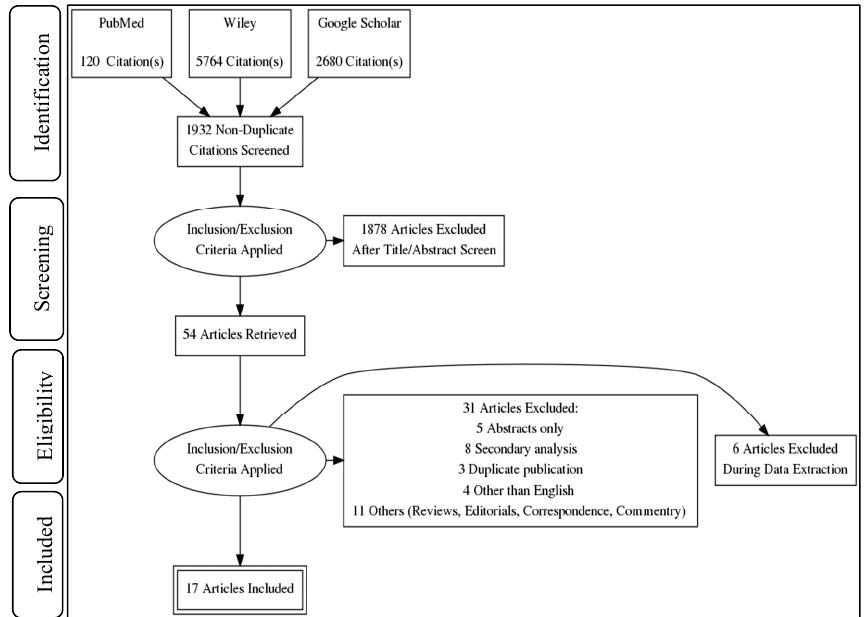
Figure 1. PRISMA flow diagram. The implementation of inclusion and exclusion criteria in a step-by-step manner determined the total number of studies in the systematic review.